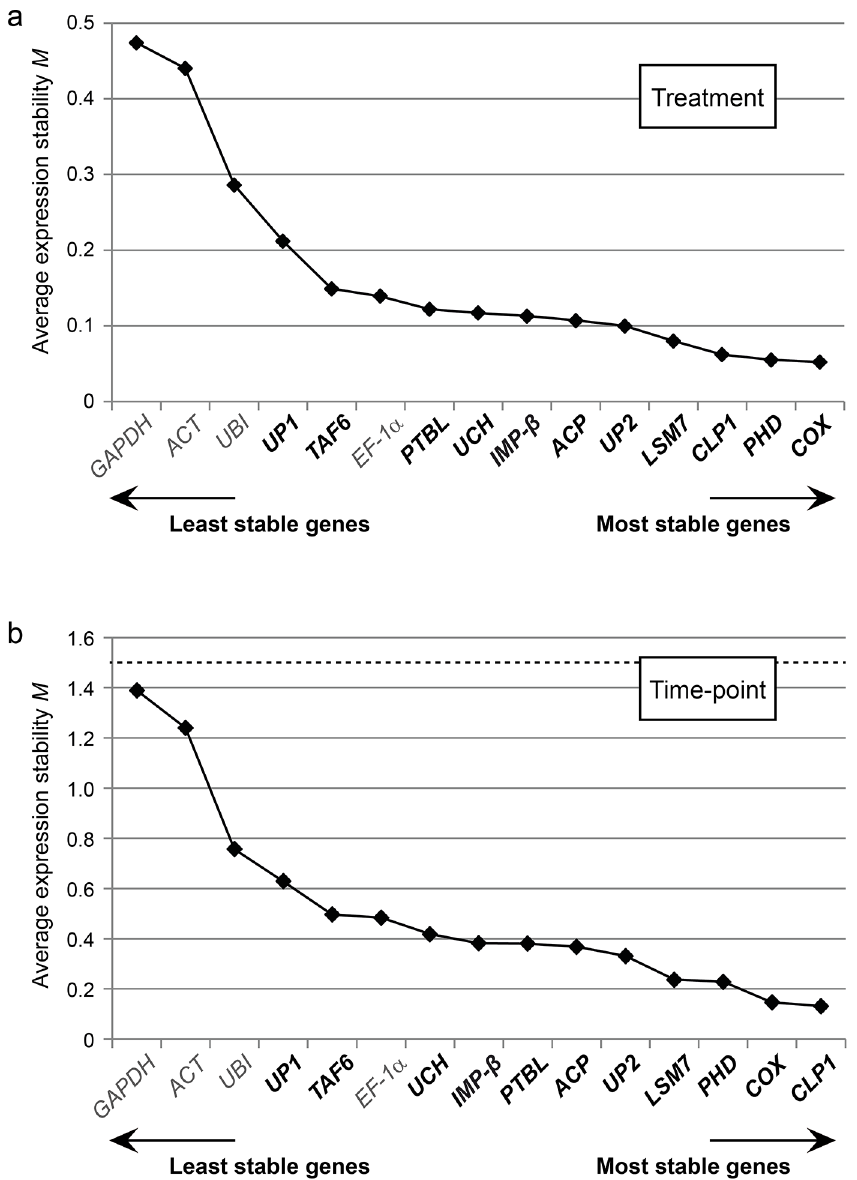
Fig 4. Expression stability of candidate reference genes in Xcv -infected and mock-treated tomato plants evaluated by NormFinder. Tomato reference genes were ranked based on expression stability calculated by NormFinder (n = 48). New reference gene candidates are indicated in bold. The cut-off value for reliable reference genes is indicated by a dashed line. Sample groups were defined based on (a)